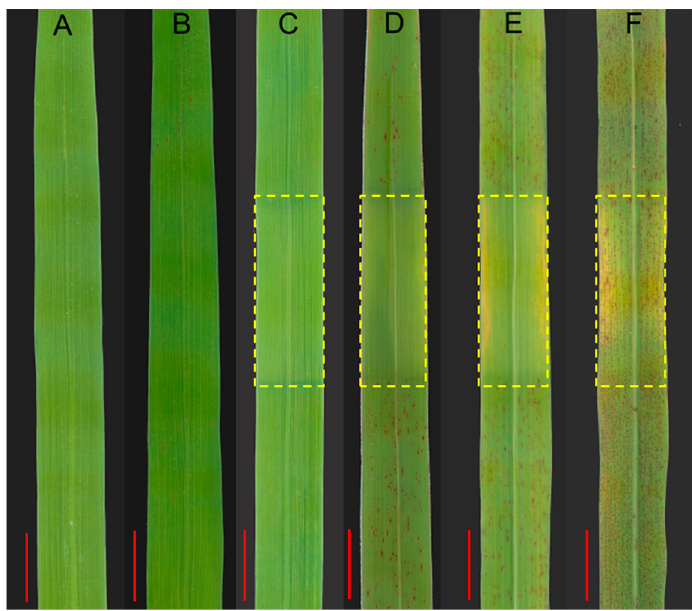
Figure 3. Light effect on lesion formation under the natural conditions. ( A ) IR64; ( B ) spl24 before shading; ( C ) IR64 shaded for 7 days; ( D ) spl24 shaded for 7 days; ( E ) spl24 reinstated for 5 days; ( F ) spl24 reinstated for 15 days. Shaded areas are boxed. bar = 1 cm.